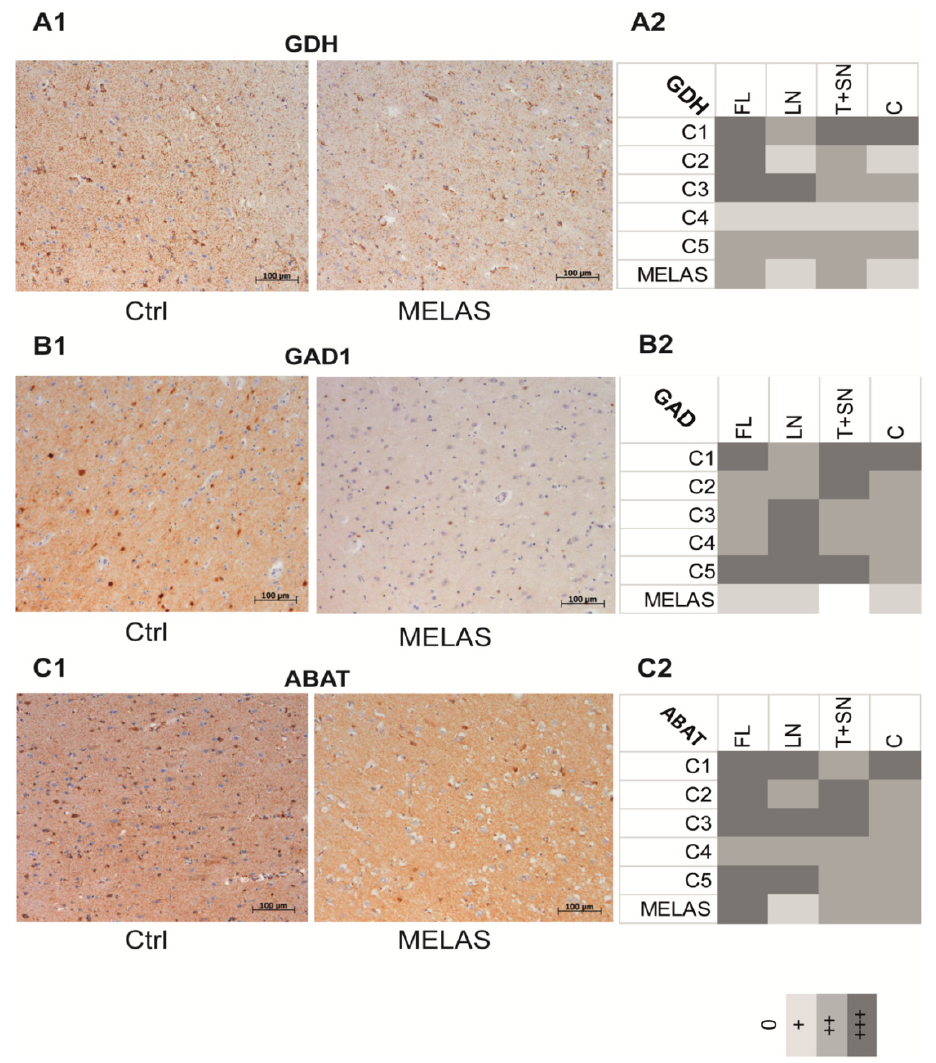
Figure 8. The glutamate pathway is altered in the brain tissue of a patient with MELAS. Immuno- histochemical analysis of paraffin-embedded human frontal brain tissue labelled with GDH ( A1 , A2 ), GAD1 ( B1 , B2 ), and ABAT ( C1 , C2 ) antibodies, from Ctrl individuals (left panel) and a patient with MELAS (right panel). Immunohistochemical staining intensities of GDH ( A2 ), GAD1 ( B2 ), and ABAT ( C2 ) were examined microscopically and scored semi-quantitatively as part of two independent analyses on five Ctrl individuals and one patient with MELAS as follows: 0 = absent, + = mild, ++ = moderate, and +++ = intense. FL: frontal lobe; LN: lentiform nucleus; T+SN: thalamus + subthalamic nucleus, C: cerebellum .